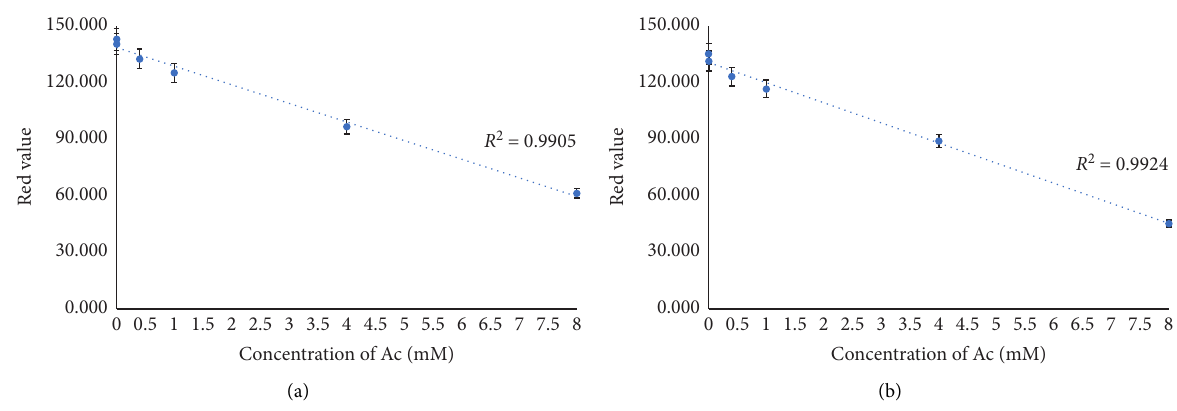
Figure 12: Fitted line plot of RVs vs. concentration for (a) Ac-Cit-HAuNPs and (b) Ac-Cit-MAuNPs